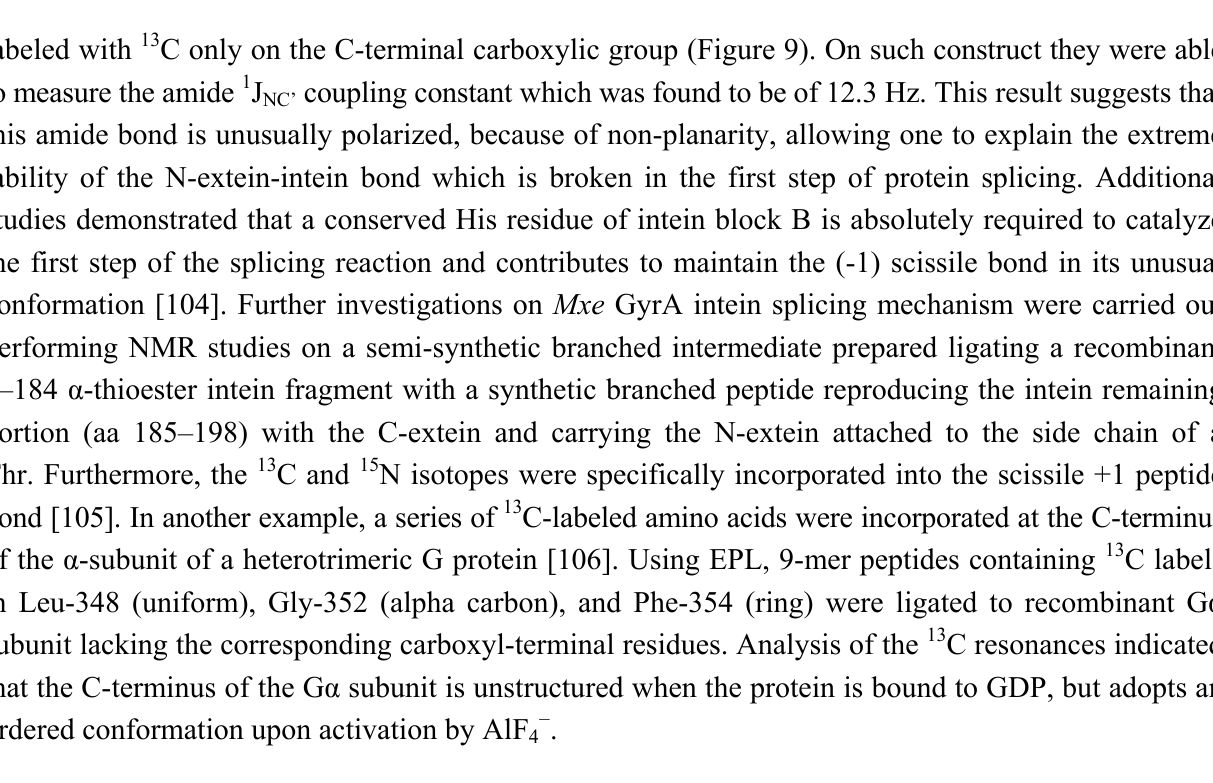
Figure 9. Semi-synthesis of Mxe GyrA intein with the scissile (-1) peptide bond dual labeled with 13 C and 15 N. Mxe GyrA intein (green) was uniformely labeled with 15 N. Extein peptide (yellow) was synthesized by SPPS with a 13 C α